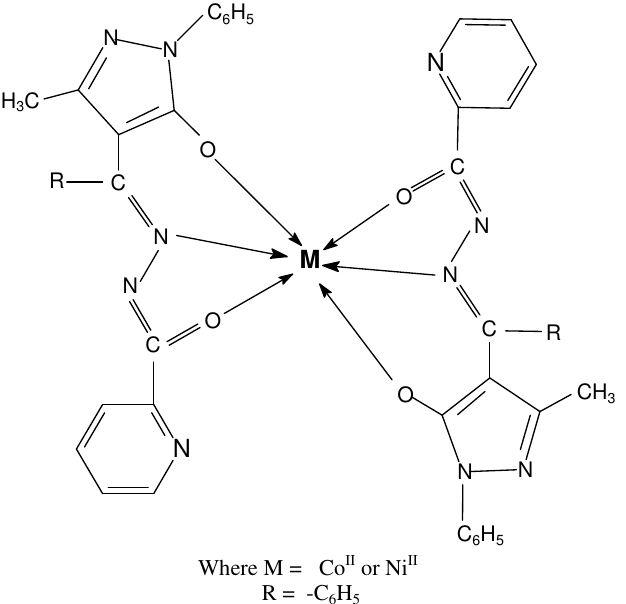
Figure 2 The probable structure of the